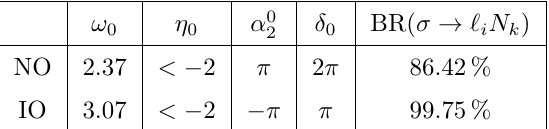
Table 5 . Largest possible branching ratios for the decay of (cid:27) (cid:6) into e (cid:6) ; (cid:22) (cid:6) . Below the given value for (cid:17) 0 , the branching ratios are to a good approximation independent of this parameter. Interestingly, the IO regime can feature a situation with a very small branching ratios into tau’s, implying approximate zeros in the third column of the Yukawa